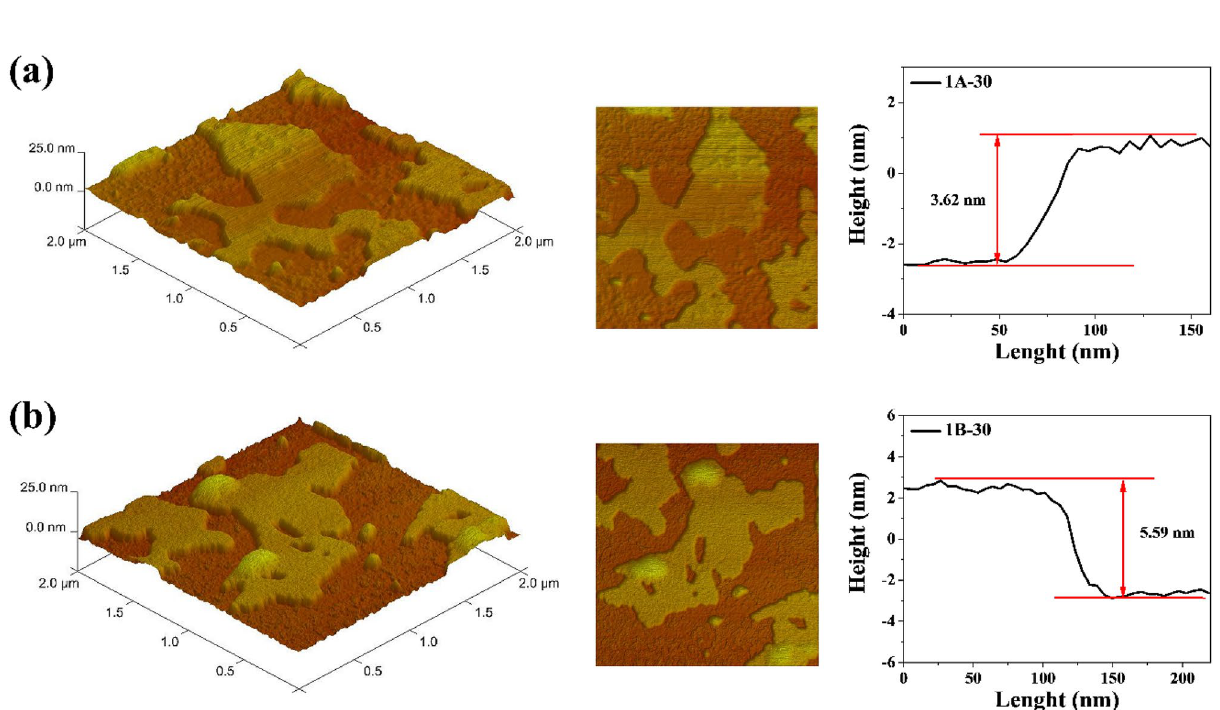
Figure 5. AFM images of ( a ) 1A-30, ( b ) 1B-30 with height profiles of graphene